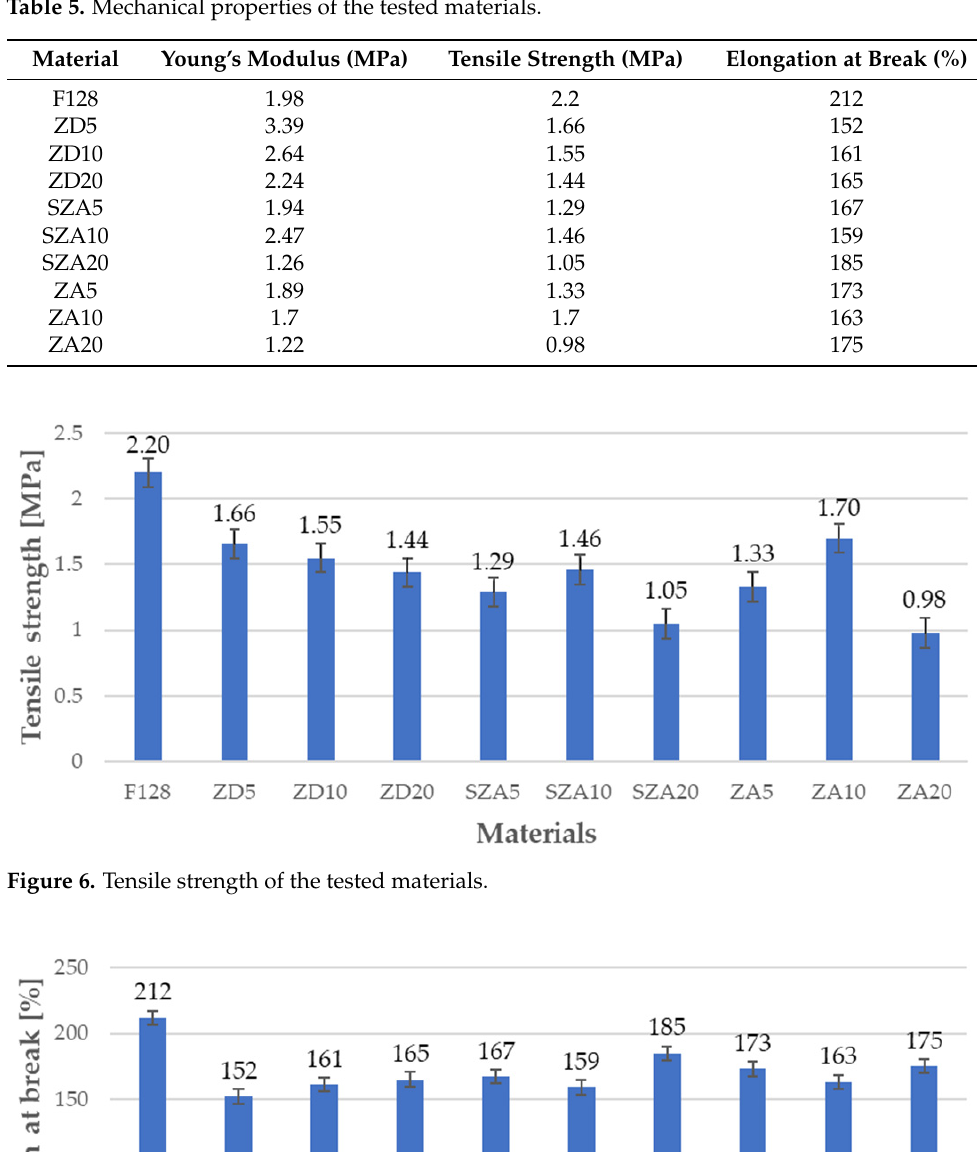
Figure 7. Elongation at break of the tested materials.